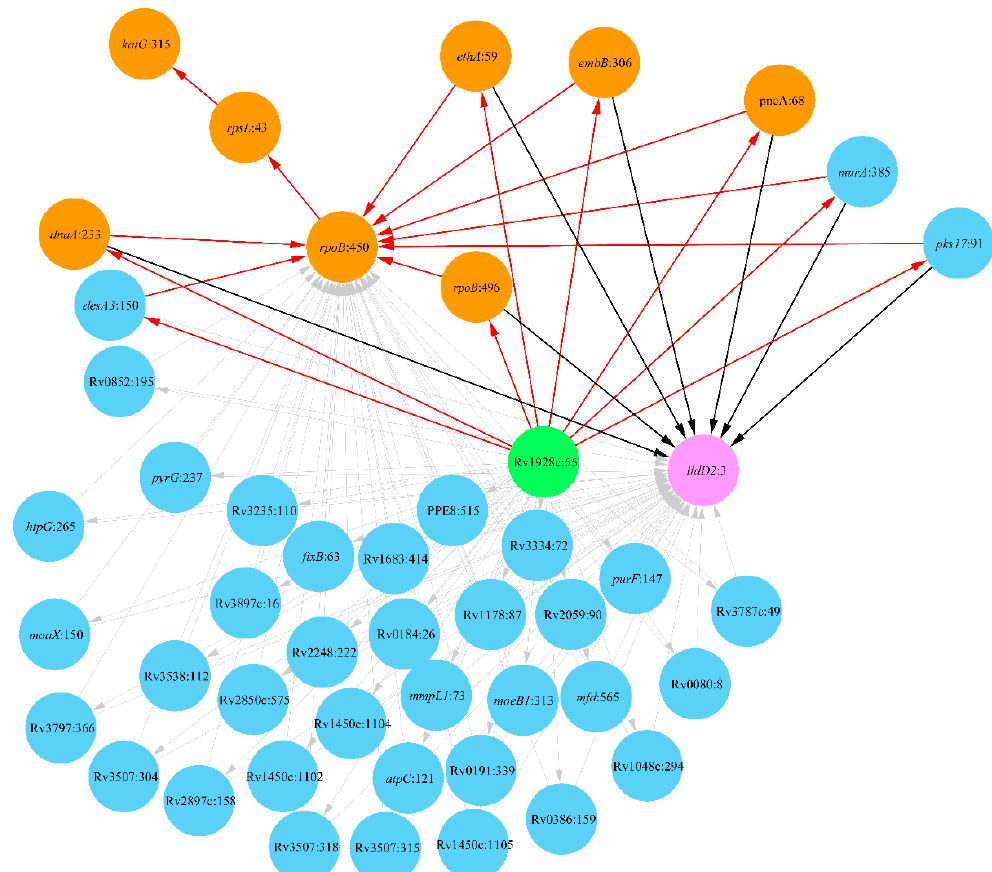
Figure 3. Network of DR-associated mutations in the clade Haarlem (Lineage 4.3). Polymorphic loci are shown as nodes titled by the respective gene name and the polymorphic codon number following the colon. Mutations known to cause DR are depicted by an orange color. Nodes linked exclusively by outgoing edges (prerequisite mutations) are shown in green, and those linked exclusively by incoming edges (final and compensatory mutations) are shown in pink, while intermediate mutations are shown in blue. Arrows show relations between prerequisite and subordinate mutations. Major steps of DR evolution in the Haarlem clade are shown as sick red arrows, and the directions to the major compensatory mutation lldD2 :3 are shown as sick black arrows.